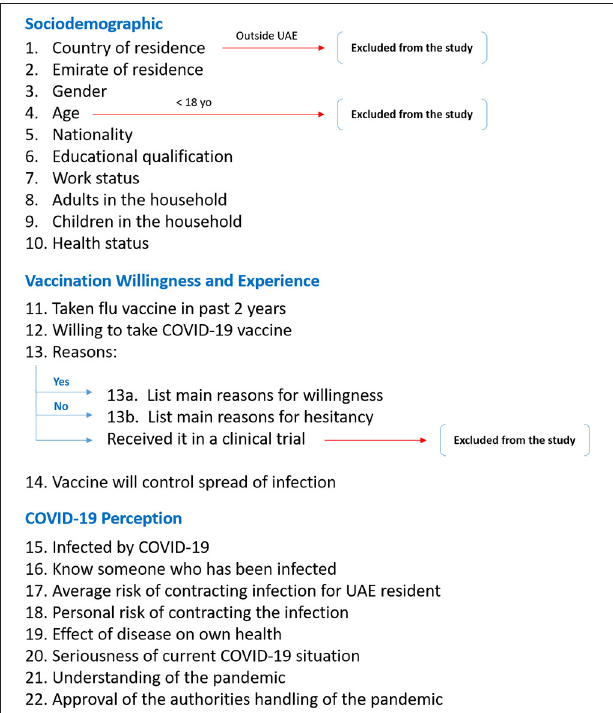
FIGURE 1 | Flow diagram of the study questionnaire. This diagram illustrates the breakdown of the questionnaire structure and the exclusion points for certain participants regarding their country of residence, age, and willingness to take the